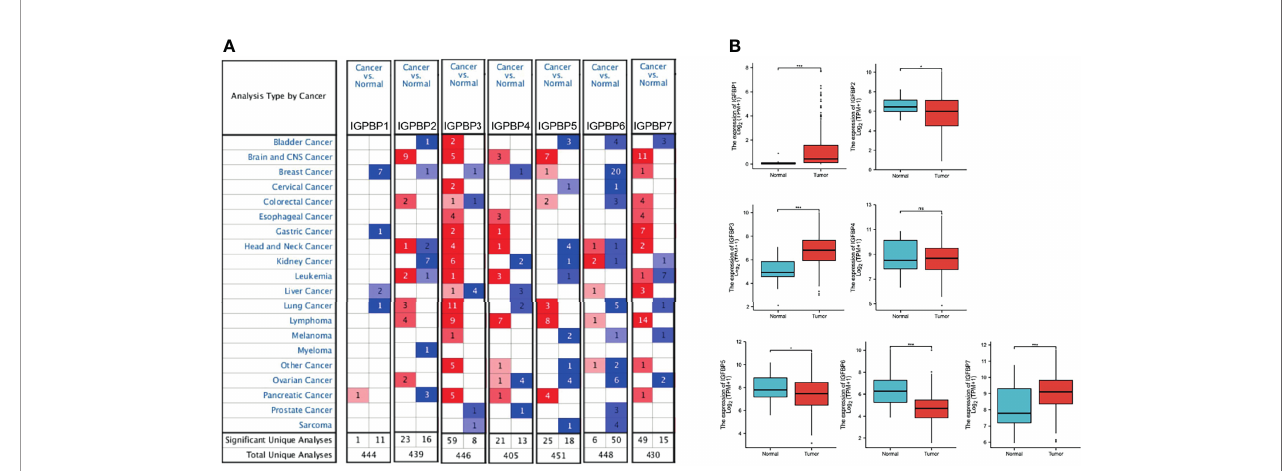
FIGURE 1 | IGFBP1 – 7 expression in STAD patients. (A) mRNA expression of IGFBP1 – 7 in different cancer types from Oncomine. The graphic shows the numbers of datasets with statistically signi fi cant alterations in the mRNA expression of the target gene: upregulated (red) and downregulated (blue). The following criteria were used: p-value: 0.01, fold change: 2, gene rank: 10%, data type: mRNA, analysis type: cancer vs . normal tissue. As shown in the green frame, transcriptional levels of IGFBP3/4/7 were signi fi cantly elevated while transcriptional levels of IGFBP1 were reduced in gastric cancer. (B) Expression of IGFBP1 – 7 in the TCGA database. *p < 0.05, ***p < 0.001.